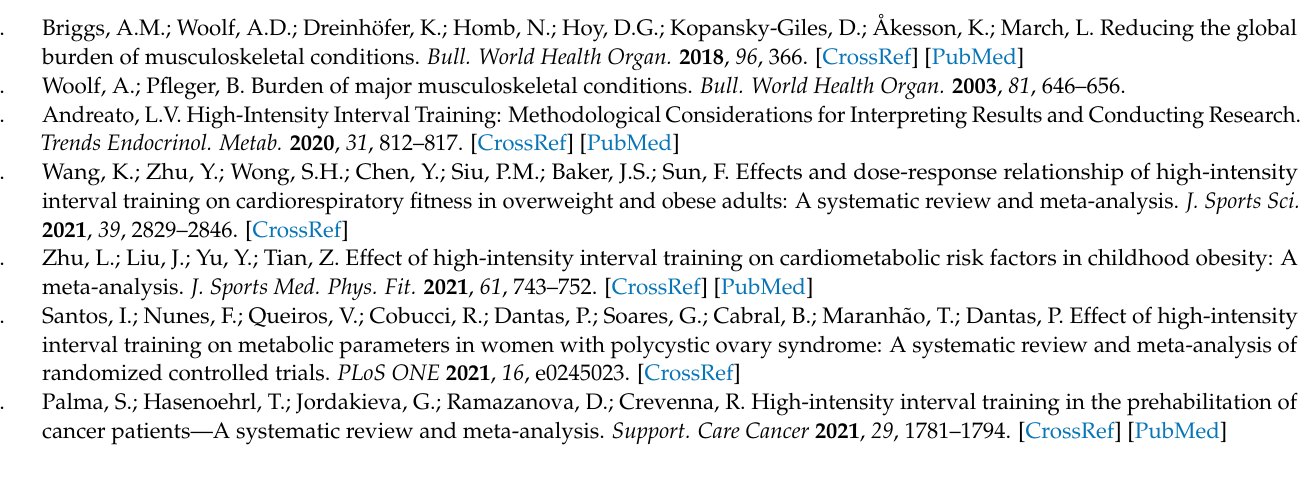
Figure A12. Synthesis funnel and Doi plot (LFK index) for C-reactive protein.